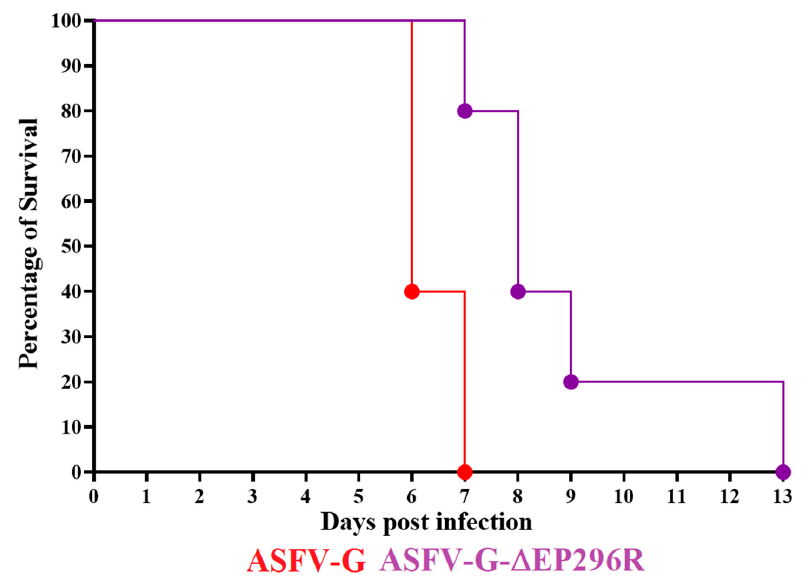
Figure 7. Evolution of mortality in animals (five animals/group) IM infected with 10 2 HAD 50 of either ASFV-G- ∆ EP296R or parental ASFV-G. Significant statistical differences were predicted between the two groups of pigs when evaluated by both the log-rank (Mantel–Cox) test ( p -value = 0.008) and the Gehan–Breslow–Wilcoxon test ( p -value = 0.009).